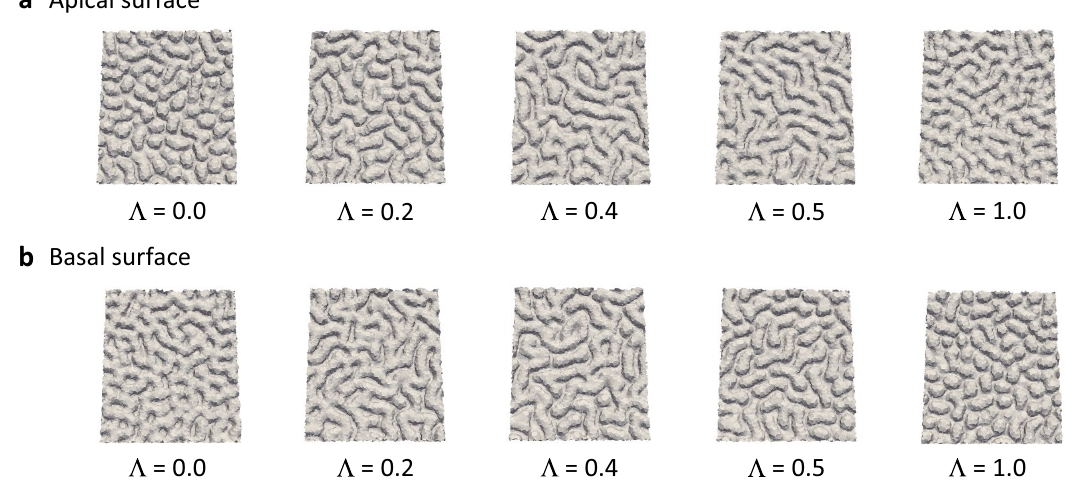
Figure 3. Snapshots of epithelial folding simulated under the conditions of (cid:31) = 0.0, 0.2, 0.4, 0.5, 1.0 . ( a ) Apical surface. ( b ) Basal surface. All snapshots show the simulation results at time t = 0.5 τ on the apical surface are shorter when the degree of asymmetry (cid:31) is small (the basal side is closer to the elastic wall), and the length of ridges increases as (cid:31) increases. The reverse occurs with the folding patterns of the basal surface: the ridges become shorter as (cid:31) becomes